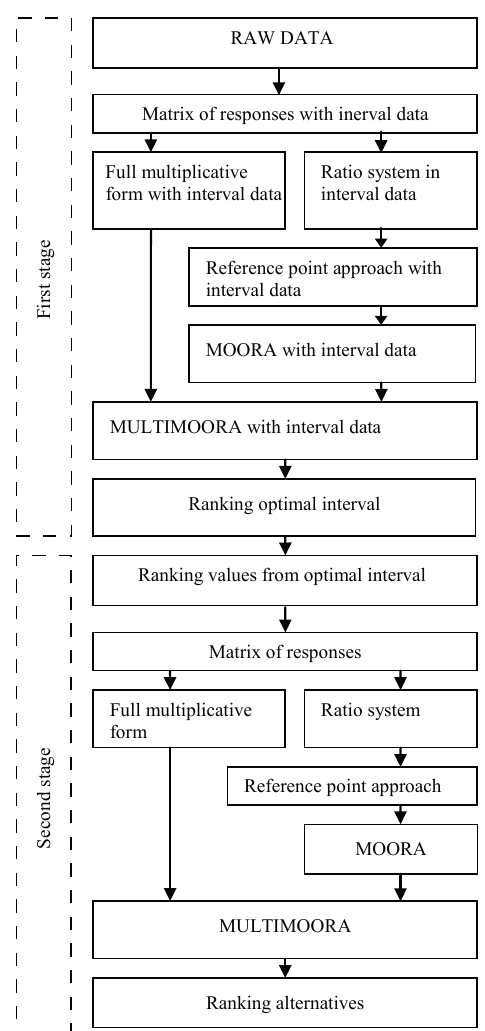
Figure 4. A graphical MULTIMOORA with interval data block